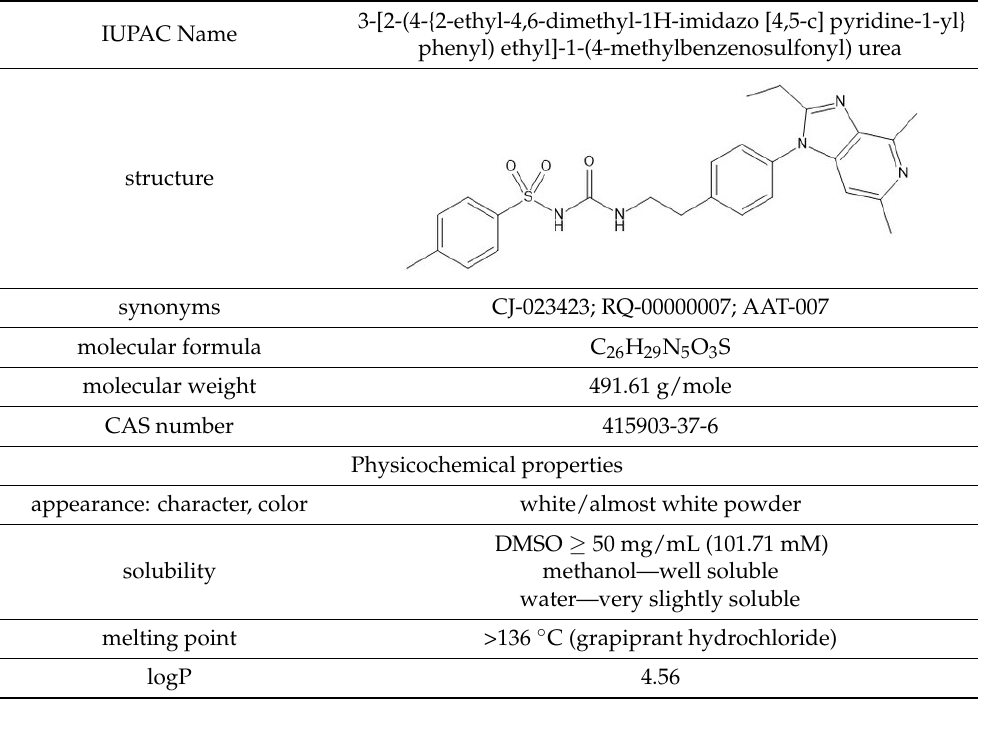
Table 1. A structure and general information on grapiprant (methylbenzenesulfonamide).